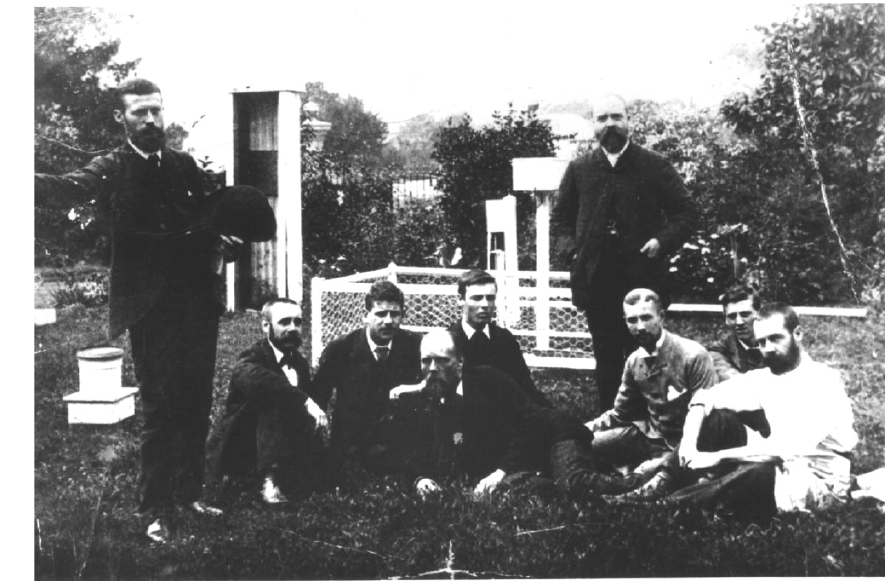
Figure 1a. O ffi cers of the Sydney Observatory, including, on the left, Charles Egeson, first meteorologist to thoroughly document an about-transtridecadal cycle in weather and to relate it to sunspots. Courtesy of Geo ff Wyatt, Acting Manager, Sydney Observatory, Sydney,